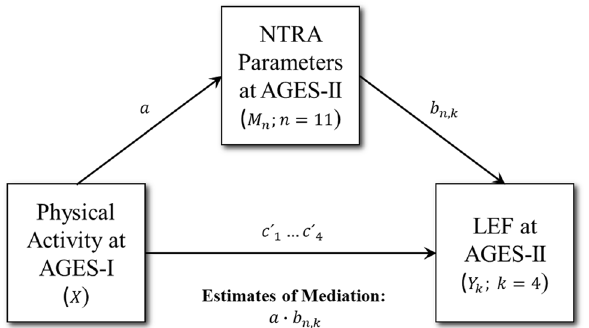
Figure 2. Conceptual path diagram for the present NTRA-based multiple mediator model, showing the theorized role of soft tissue radiodensity changes (characterized by eleven NTRA parameters) on the longitudinal relationship between physical activity and our four LEF